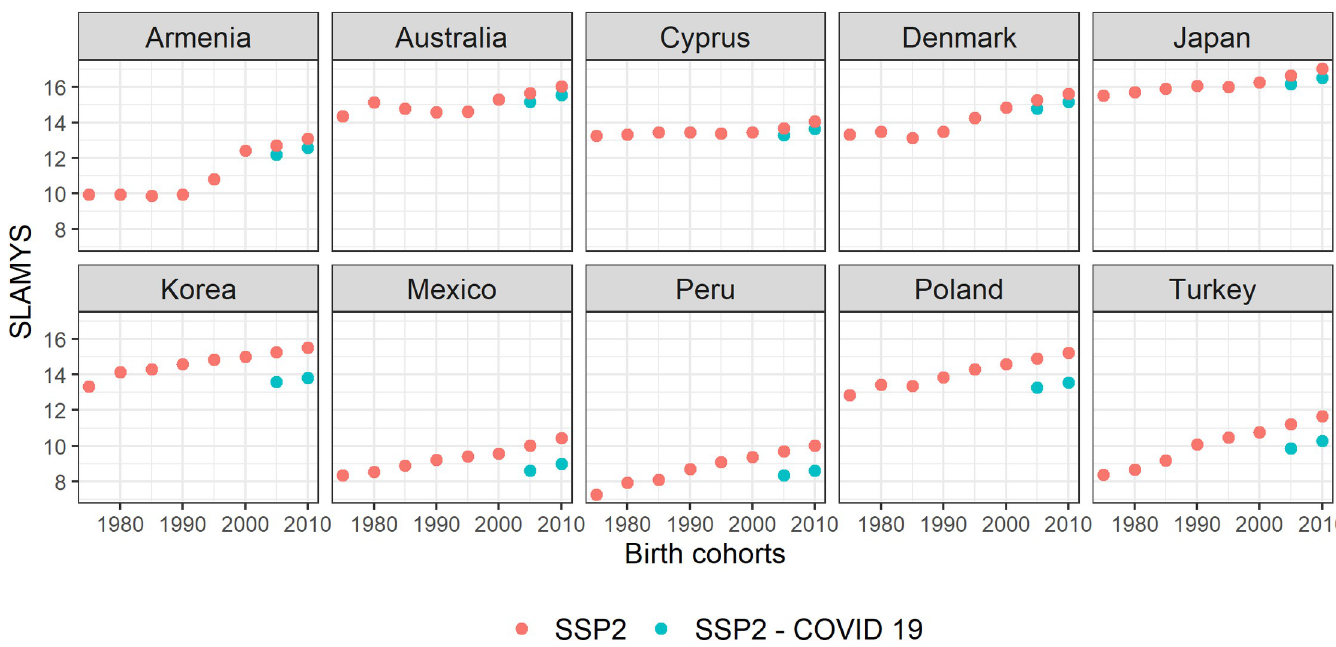
Fig 5. Projected SLAMYS (SSP2) for 40–44 year-olds across birth cohorts. Source: Authors’ own calculations.